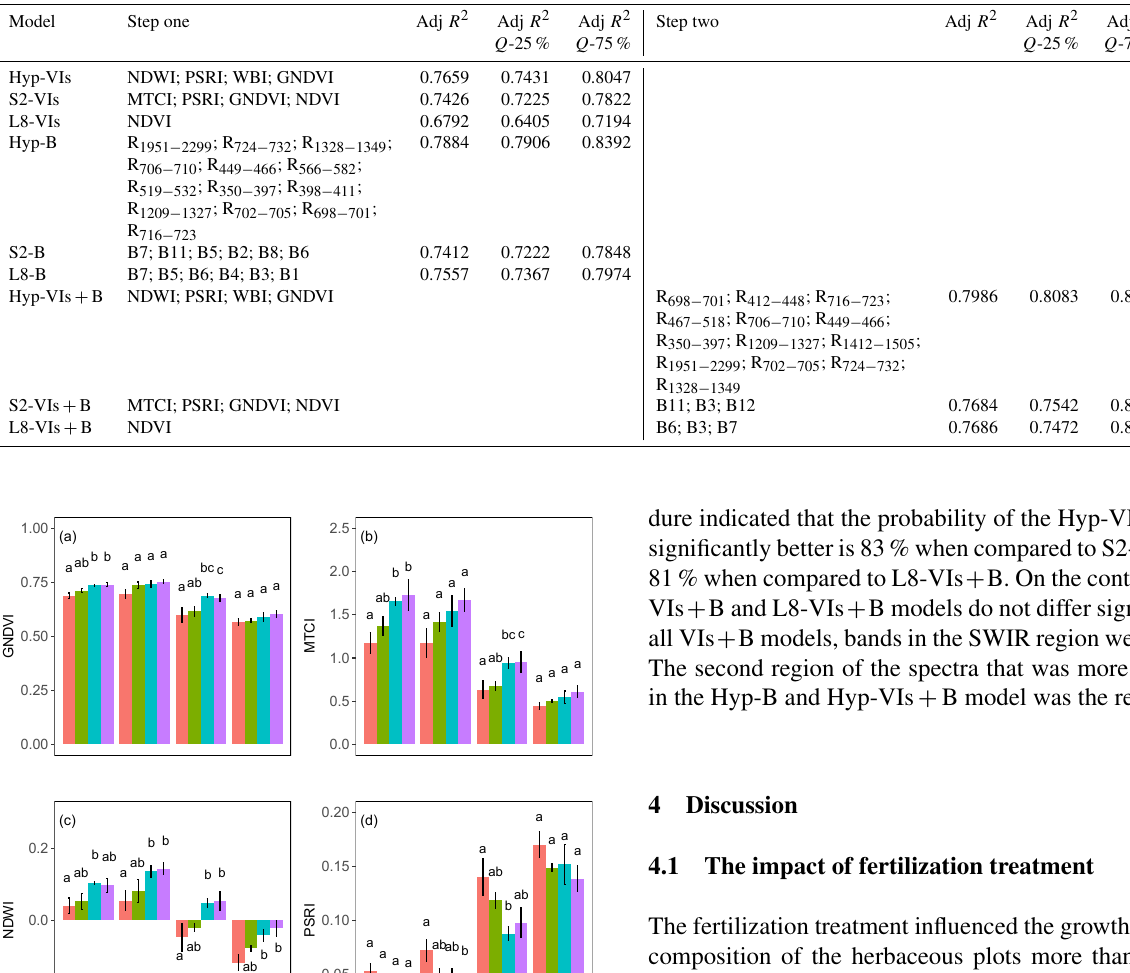
Table 5. Best selection of linear models for a GPP estimate according to the general equation: lnGPPP ∼ indices (VIs) or optical bands (B). Bands and vegetation indices are obtained from hyperspectral measurements grouped in clusters with 90% similarity (Hyp) or resampled for simulating Sentinel-2 MSI (S2) and Landsat 8 OLI (L8) sensors. Formulation of vegetation indices is shown in Table 2. The order of the variables (most important first) reflects their importance in the model. The quantiles 25% and 75% of the adj R 2 are obtained from a bootstrap with 10000 iterations. The two-step models add a selection of bands to the variables (VIs) selected at step 1. A low p value indicates that the step 2 model, including VIs and bands (step 2) is significantly better the corresponding step 1 model.